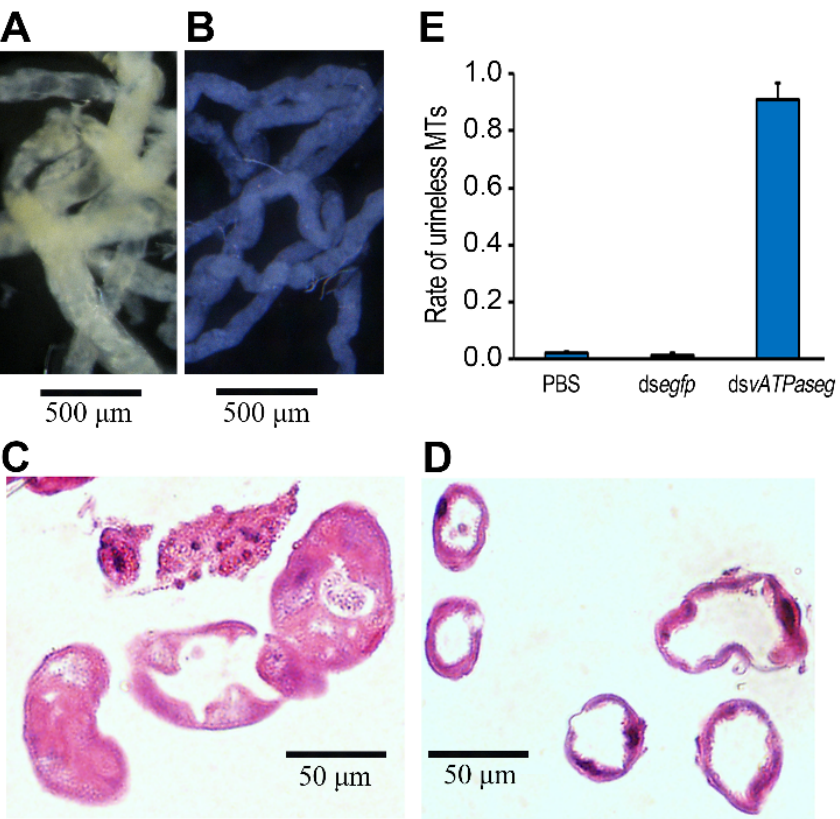
Figure 4. A characteristic phenotype in Malpighian tubules in ds vATPaseG -fed larvae in Henosepilachna vigintioctopunctata . The newly-ecdysed fourth instar larvae had ingested PBS-, ds egfp - , and ds vATPaseG -dipped leaves for three days. The Malpighian tubules were dissected and collected 5 days after the initiation of bioassay ( A ). The Malpighian tubules from ds egfp -fed larvae are opaque. In contrast, the tubules in ds vATPaseG -fed larvae are clear. The hematoxylin-eosin (HE) staining shows that the tubules from ds egfp -fed larvae are full of urine ( B ), whereas most of the tubules in ds vATPaseG -fed larvae are empty ( C , D ). The rates of urineless Malpighian tubules were calculated ( E